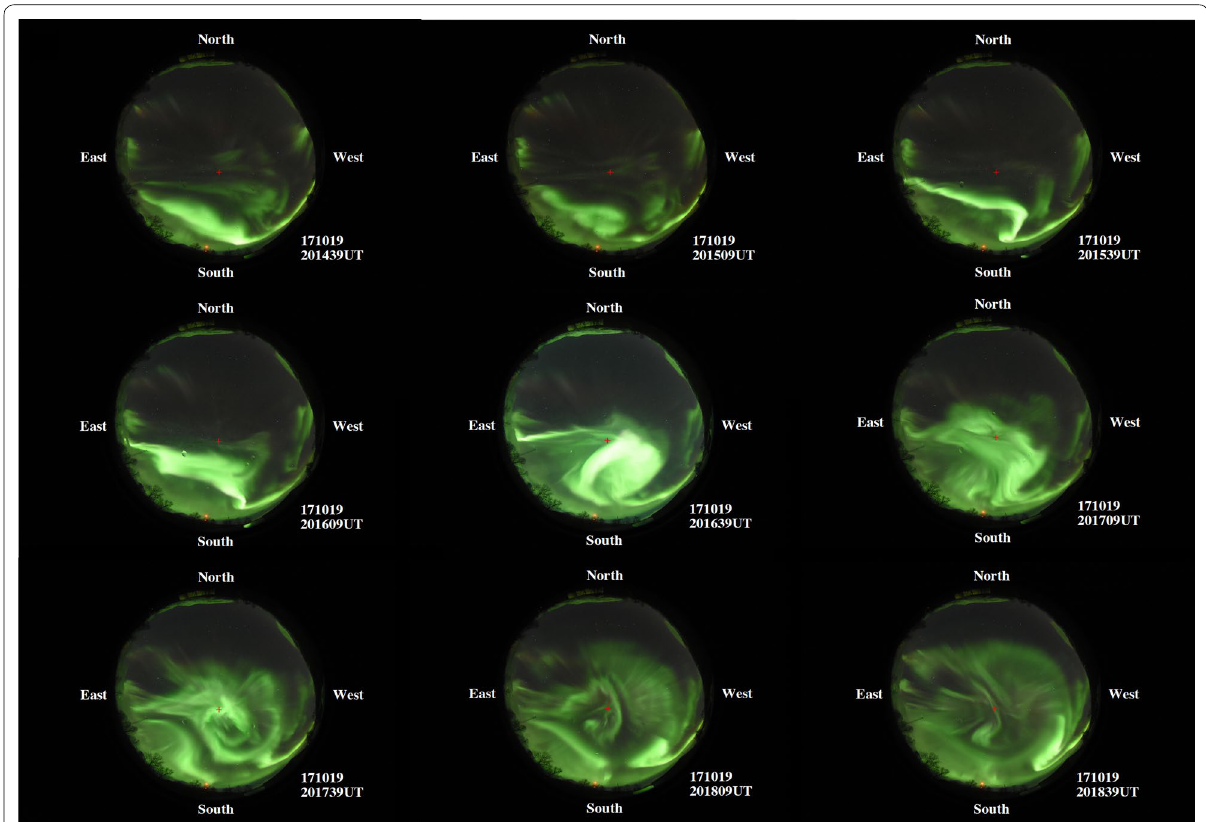
Fig. 6 All-sky images taken with a digital camera (Nikon D7200) every 30 s with an exposure time of 8 s between 20:14:39 UT and 20:19:39 UT on October 19, 2017. The field-aligned position, where the photometer was pointed, was indicated by a red plus sign (